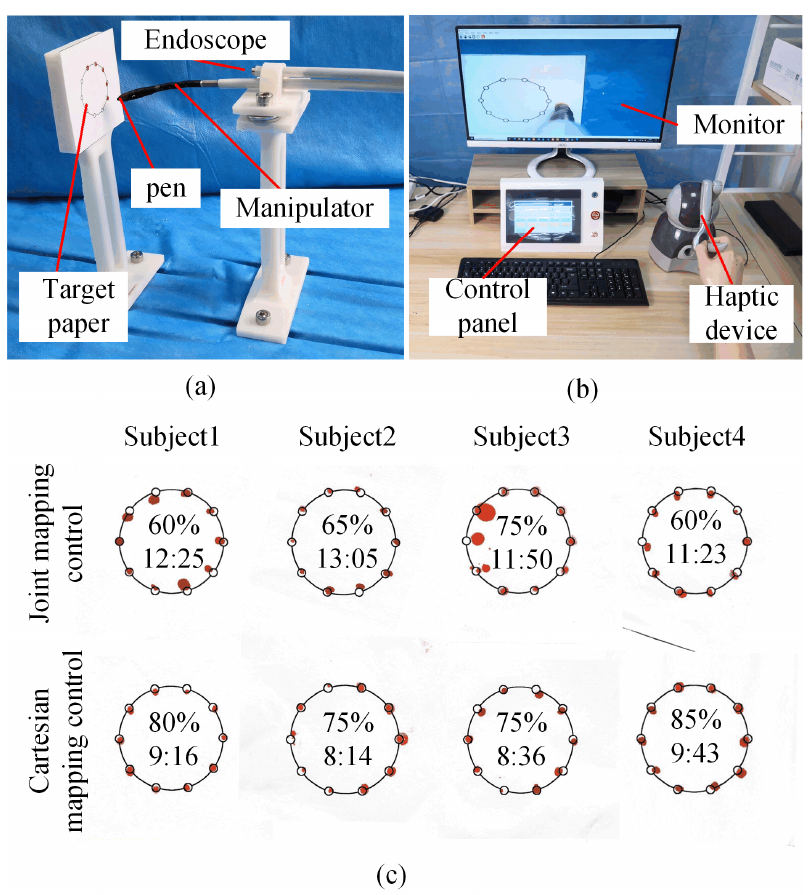
Figure 12. Test for master–slave control: ( a ) Slave side of experiment setup for master–slave control test; ( b ) Master side of experiment setup for primary–secondary control test; ( c ). Experiment result of master–slave control.